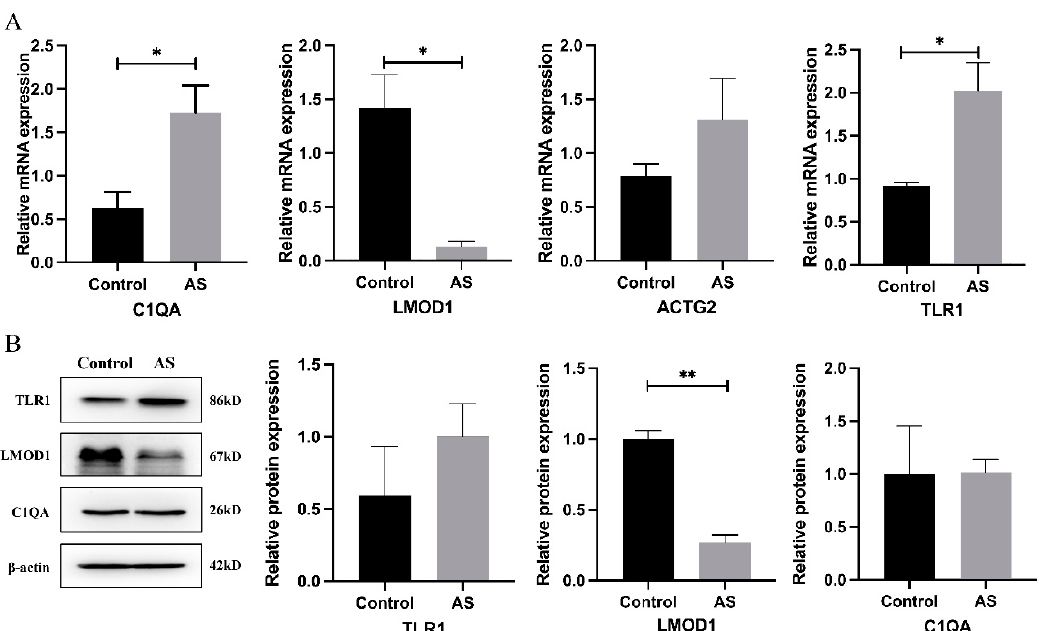
Figure 13. The mRNA levels and protein levels of candidate hub genes were detected in peripheral blood mononuclear cells (PBMCs) from arteriosclerotic patients and matched control subjects by RT-qPCR and Western blot analysis. ( A ) The mRNA levels of four candidate hub genes by RT-qPCR analysis (* p < 0.05). ( B ) The protein levels of three candidate hub genes by Western blotting, with relative protein quantification of Western blotting by densitometric analysis. * p < 0.05; ** p < 0.01.